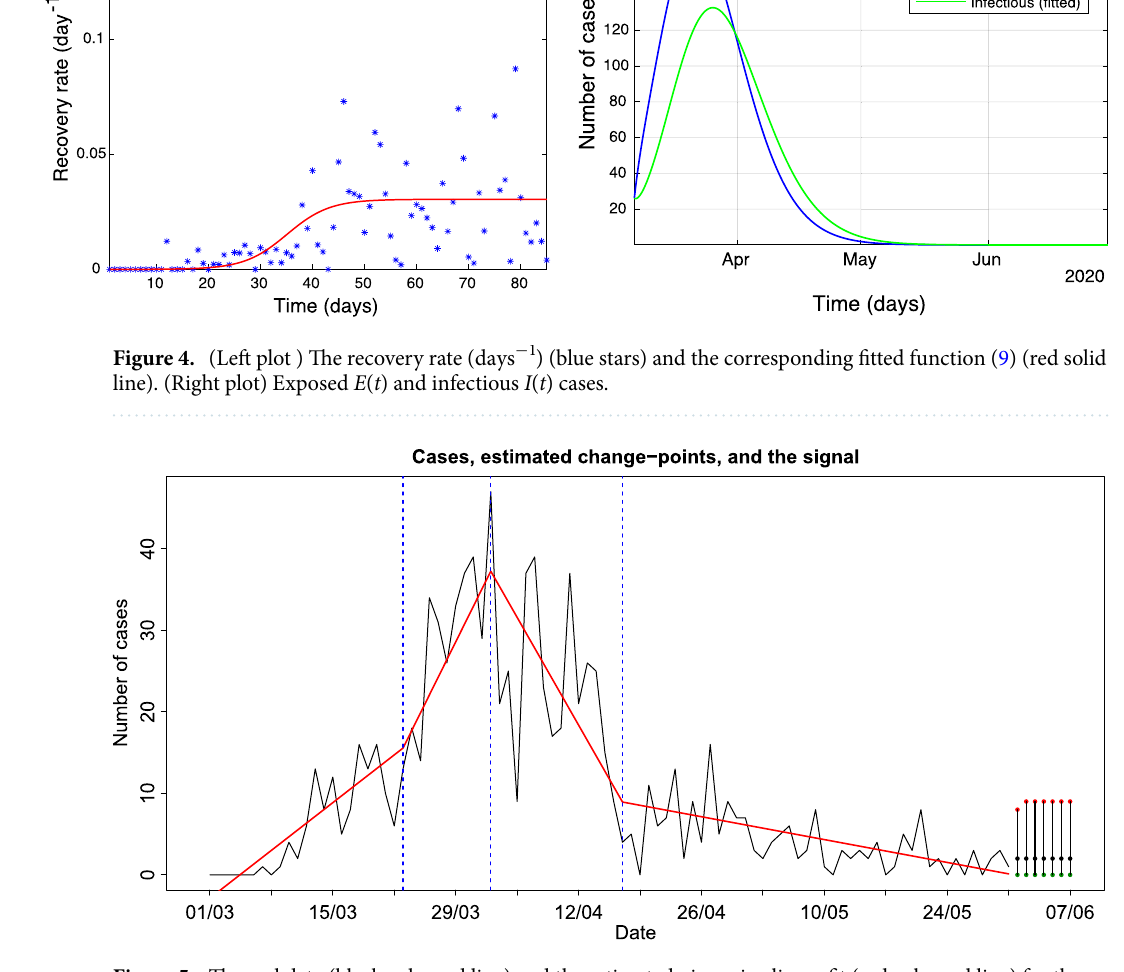
Figure 5. The real data (black coloured line) and the estimated piecewise-linear fit (red coloured line) for the daily incidence rate. The change-point locations are given with dotted, blue vertical lines. At the right-end of the plot point estimators (black dots) and 95% prediction intervals for the number of daily cases for the next week are